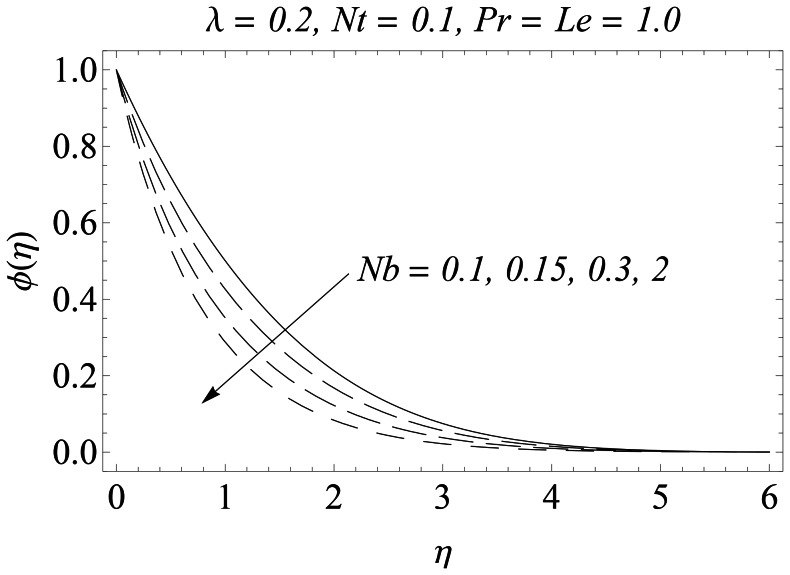
Influence of Nb on .